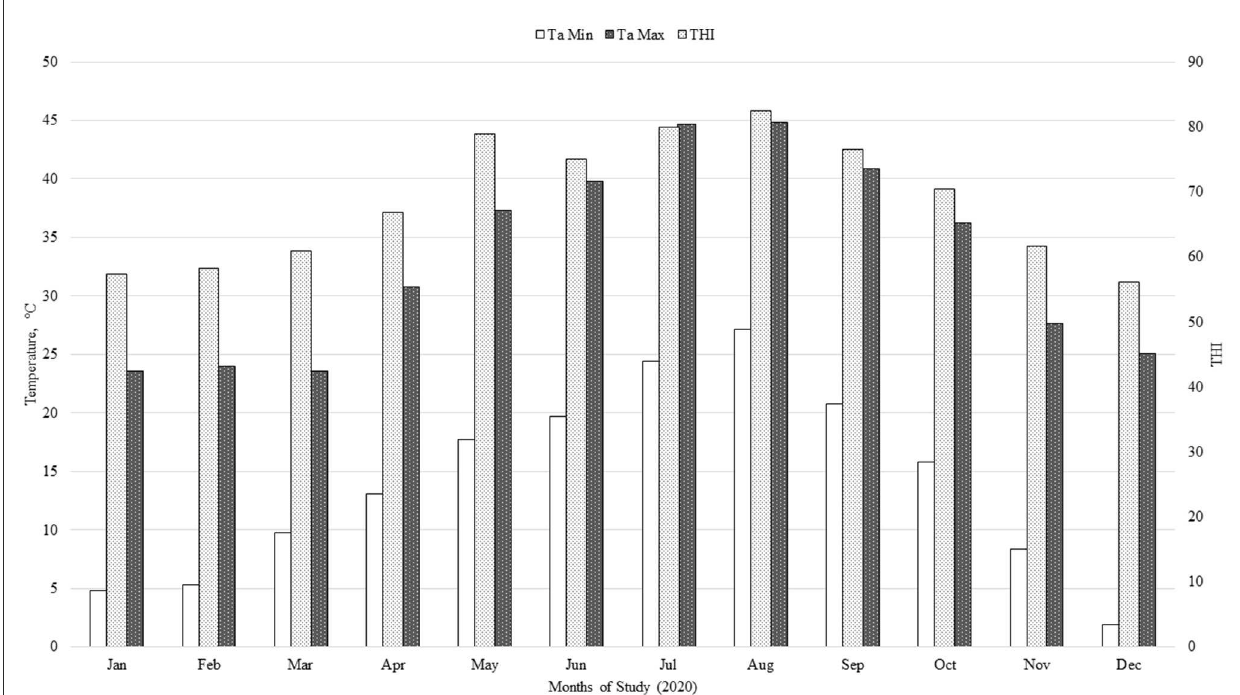
FIGURE1 Temperature-humidity index (THI) during the 286-d feeding period: THI and H is relative humidity (16, 17); Min